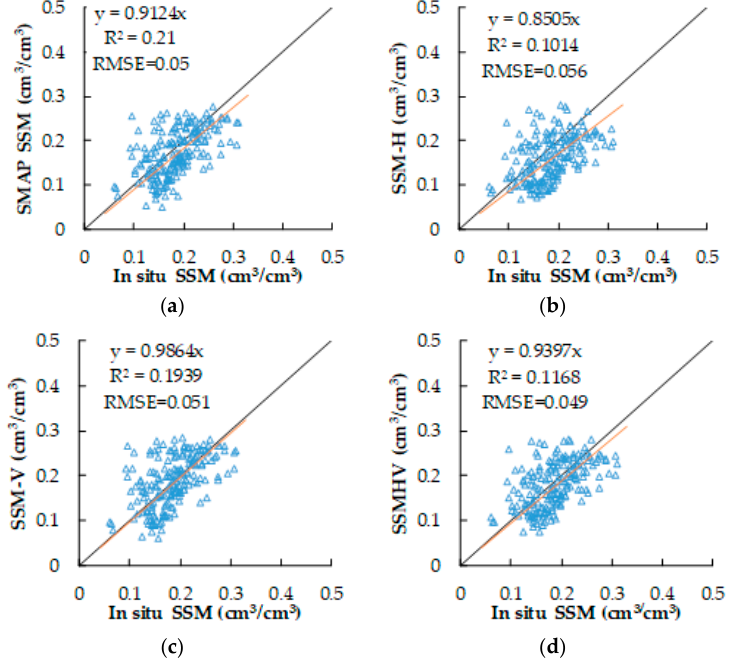
Figure 10. Comparison of in situ SSM values (cm 3 /cm 3 ) and retrieved SSM values (cm 3 /cm 3 ) for descending orbit from 2016–2018. ( a ) SMAP L3, ( b ) H pol, ( c ) V pol, (d) 0.5(H + V). The black line is the 1:1 line and the brown line is the fitted linear equation.